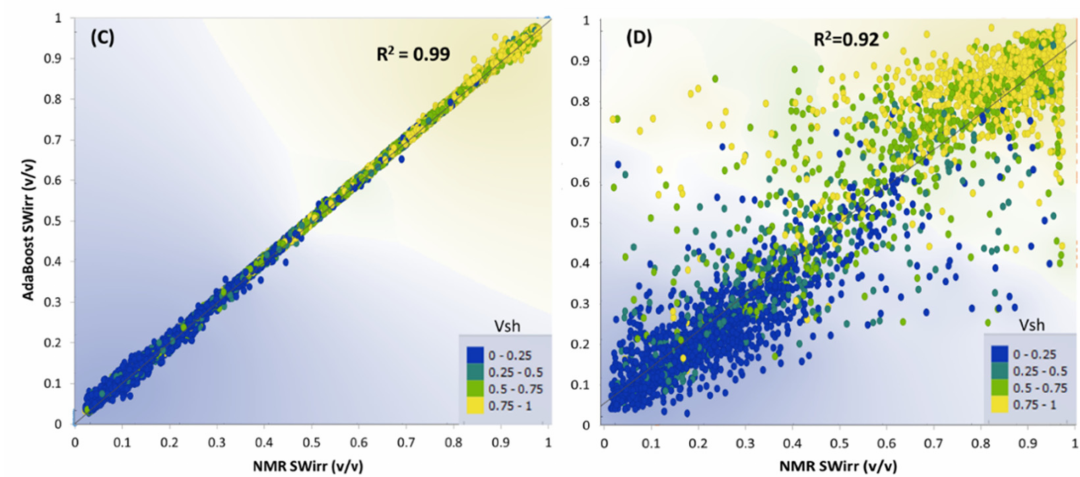
Figure 7. AdaBoost performance for prediction of T 2 LM and S wirr in training ( A , C ) and blind ( B , D ) datasets.